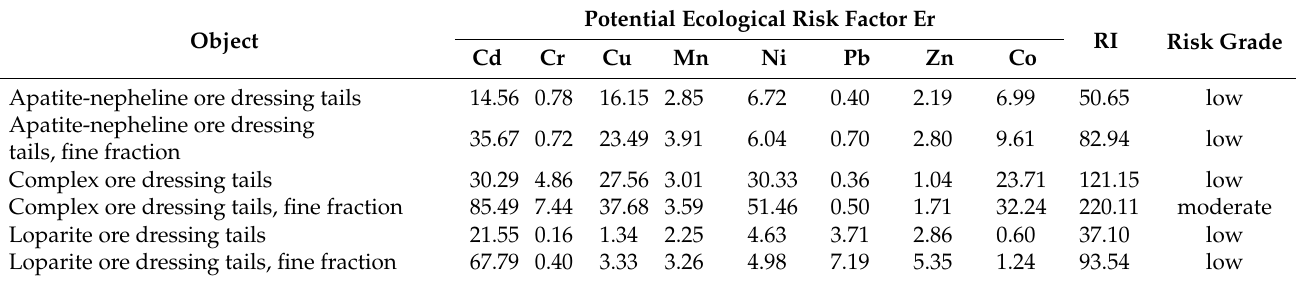
Table 6. The potential ecological risk index factor Eir and the potential ecological risk index